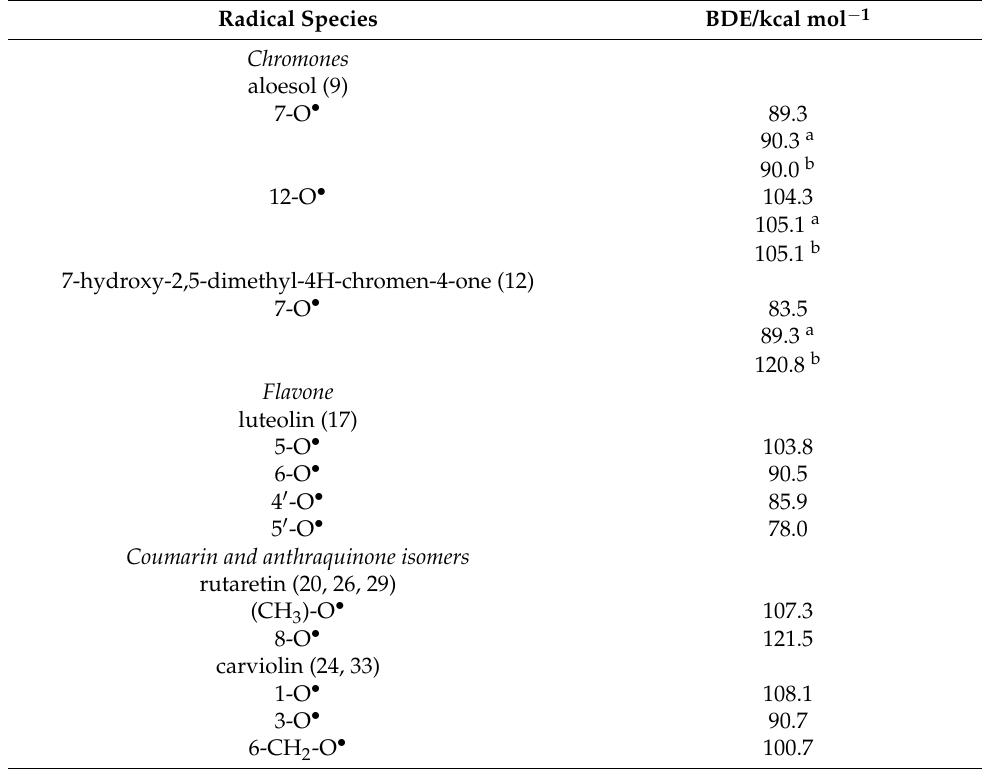
Table 3. Bond dissociation enthalpies (BDEs) corresponding to the formation of radical species for the isolated compounds in this